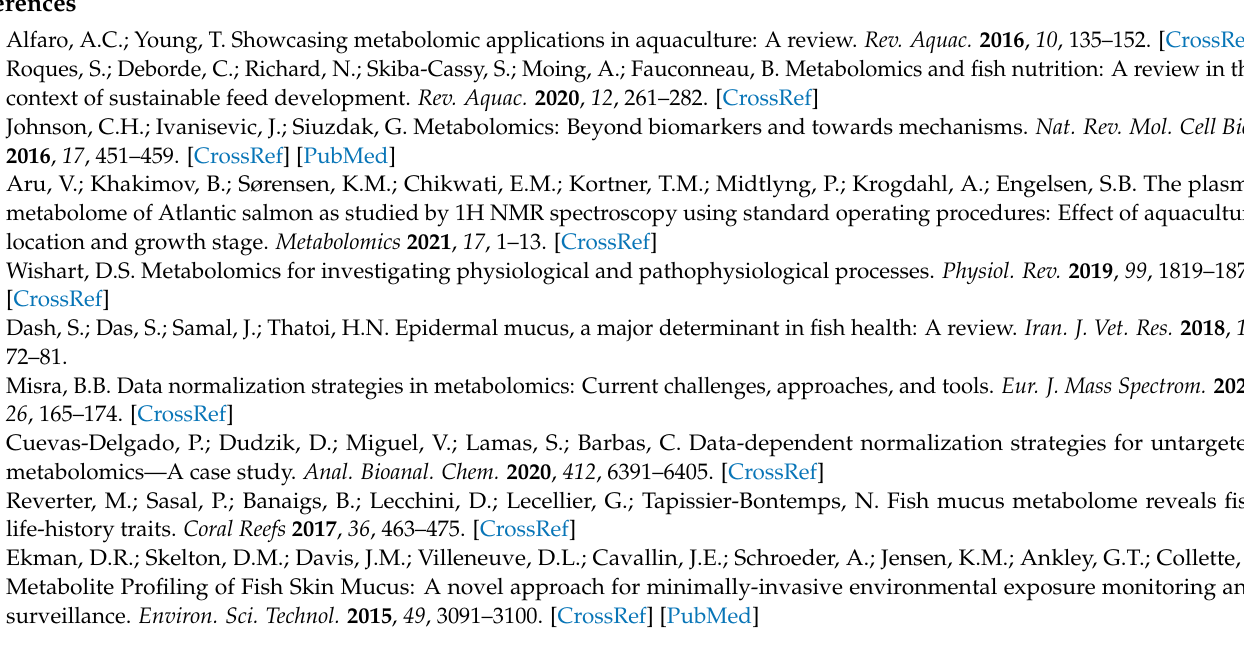
a dendrograms, Figure S2: Relative differences between gill and skin mucus metabolites from salmon euthanized using benzocaine or percussive stunning (“Control”), Absolute IDQp400 kit, Figure S3 Heatmap ( t -test/ANOVA) exhibiting different concentration patterns of metabolites in skin and gill mucus, Absolute IDQp400 kit, Table S1: Total protein content in gill and skim mucus samples, Table S2: Metabolite concentrations in skin and gill mucus, Absolute IDQ p400 kit,